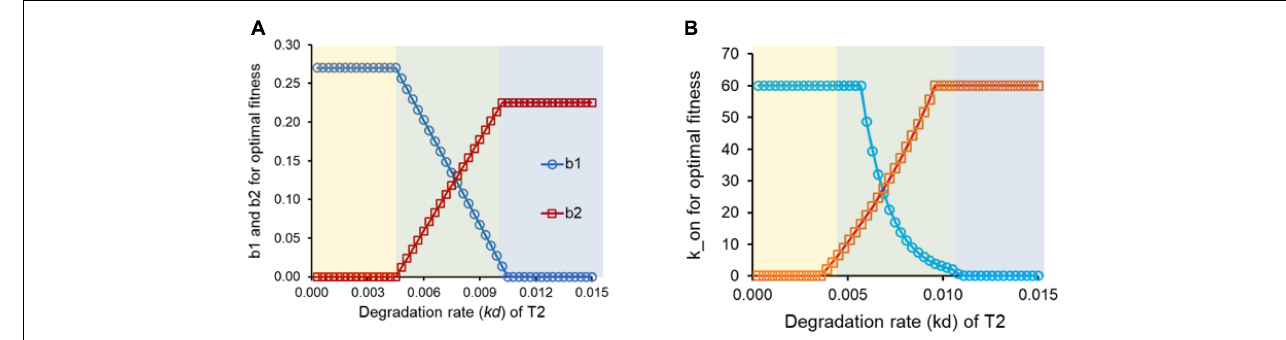
FIGURE 2 | (A) For intermediate values of the degradation rate kd for target protein, T2, conditioning is the optimal response. (B) For intermediate values of the degradation rate kd for target protein, T2, conditioning is the optimal response.